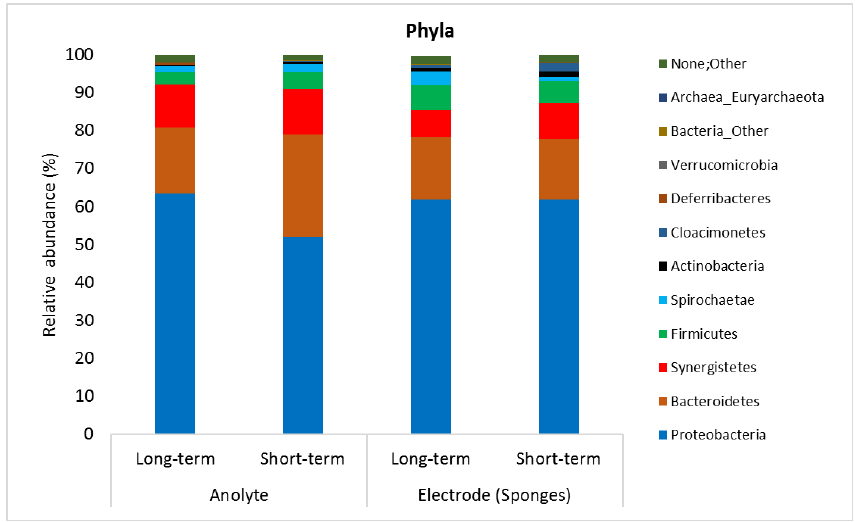
Figure 10. Bacterial communities in the bioanodes of Microbial Fuel Cell in a long-term (70 days from PU/AC Inoculum) and short-term (28 days from PU/AC I) operation.